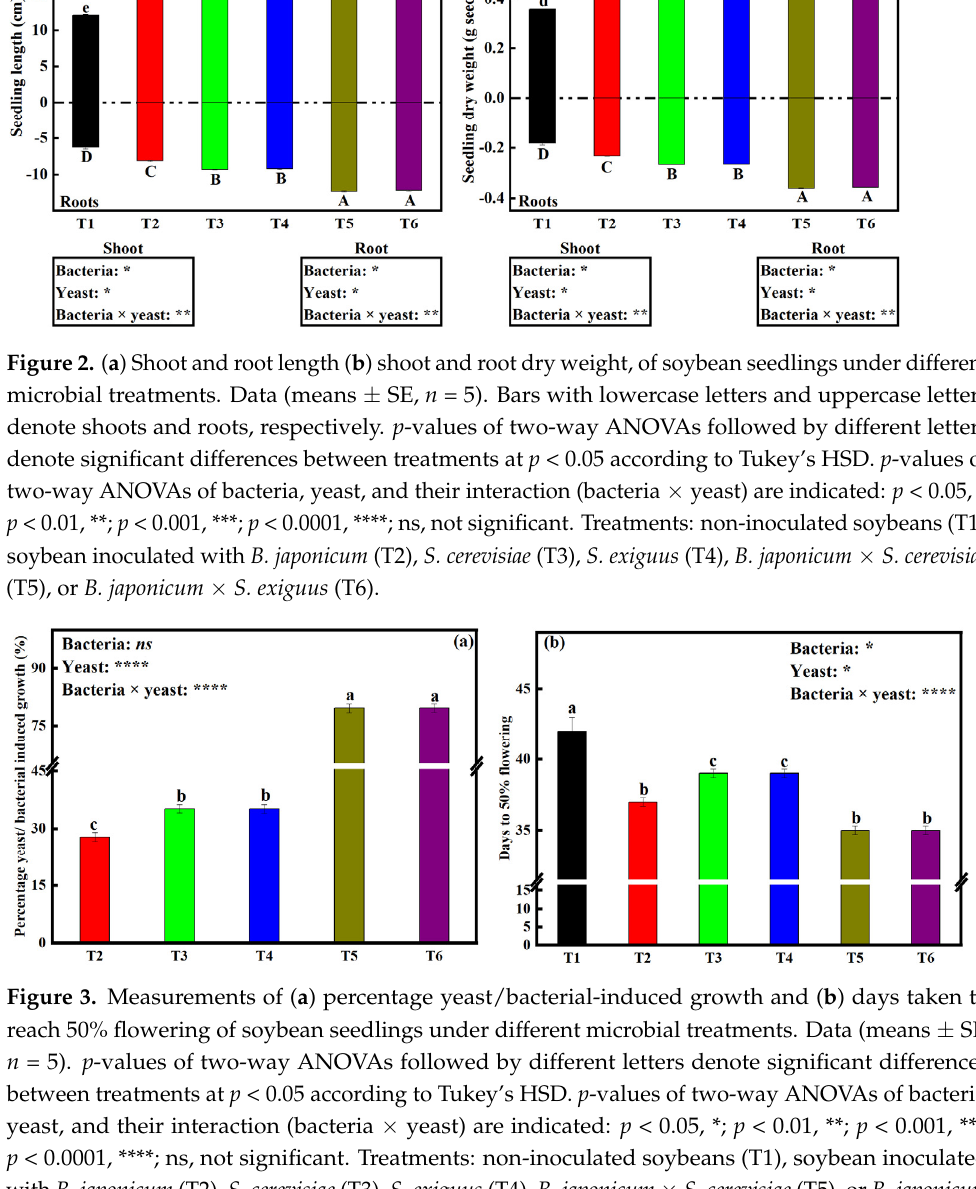
Figure 2. ( a ) Shoot and root length ( b ) shoot and root dry weight, of soybean seedlings under dif- ferent microbial treatments. Data (means ± SE, n = 5). Bars with lowercase letters and uppercase letters denote shoots and roots, respectively. p -values of two-way ANOVAs followed by different letters denote significant differences between treatments at p < 0.05 according to Tukey’s HSD. p - values of two-way ANOVAs of bacteria, yeast, and their interaction (bacteria × yeast) are indicated: p < 0.05, *; p < 0.01, **; p < 0.001, ***; p < 0.0001, ****; ns, not significant. Treatments: non-inoculated soybeans (T1), soybean inoculated with B. japonicum (T2), S. cerevisiae (T3), S. exiguus (T4), B. japoni- cum × S. cerevisiae (T5), or B. japonicum × S. exiguus (T6).